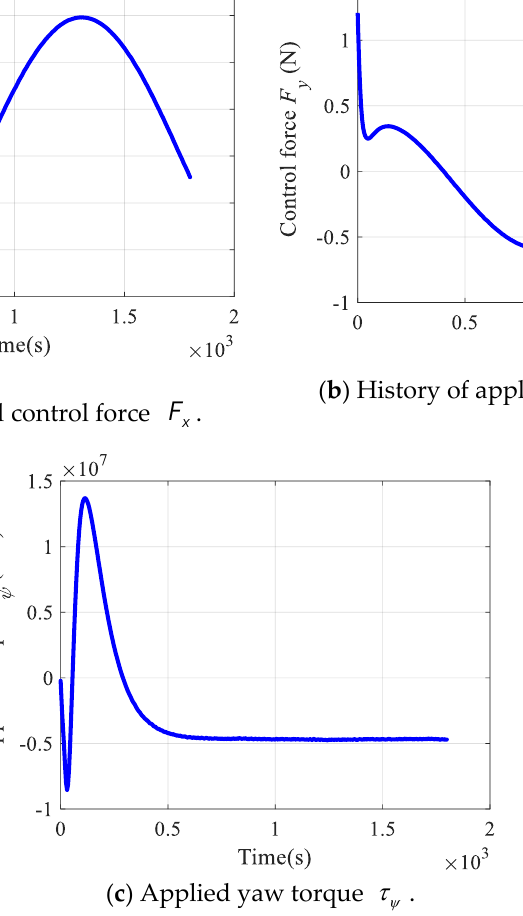
Figure 6. Control commands of controlled AUSV.